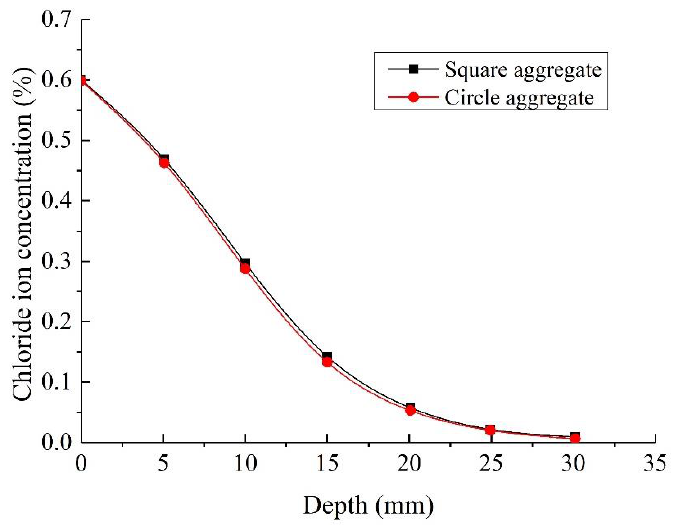
Figure 15. Chloride ion concentration of specimen HPC50 with different aggregate shape.